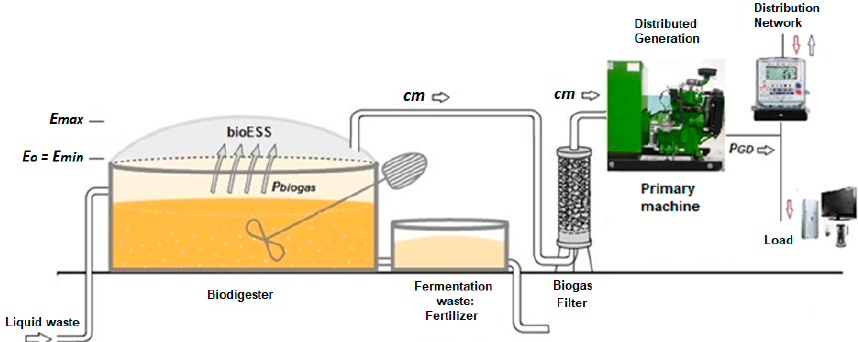
Figure 8. DG with bioESS and factors that influence its management.